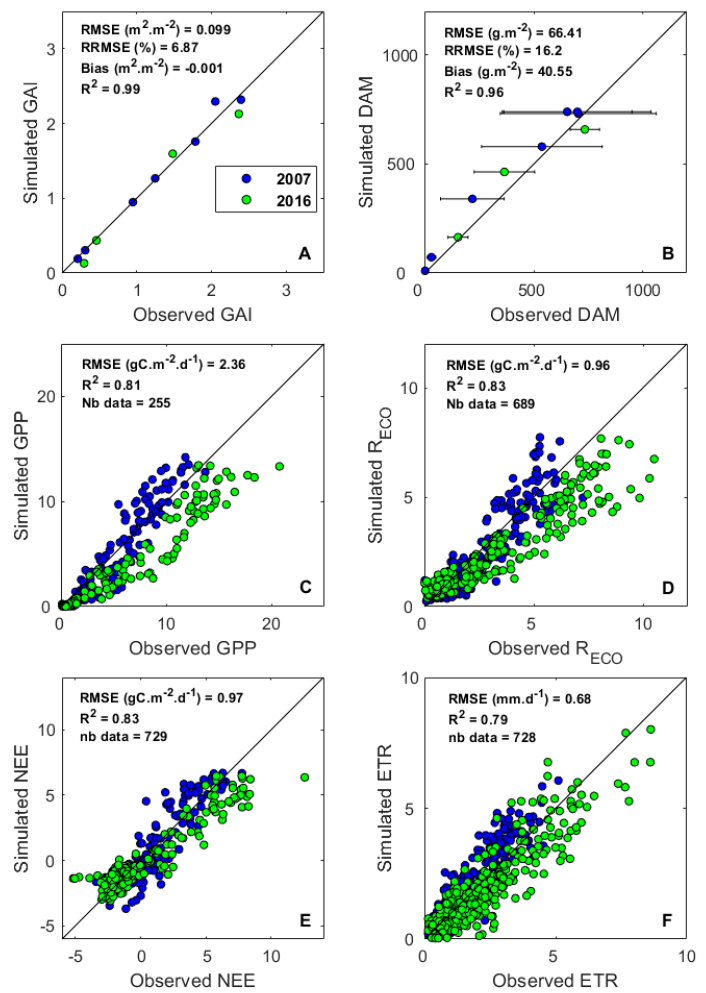
Figure 5. Scatter plots of the observed and simulated GAI ( A ), DAM ( B ), GPP ( C ), R ECO ( D ), NEE ( E ), and ETR ( F ) for the two crop years of sunflower at FR ‐ Aur and mean statistic over the 2 crop years. − 2 · − 1 0.96 gC · m d , respectively, and rRMSE of 39.5% and 40.9%, respectively) and good correlations (R 2 GPP and R ECO are estimated with relatively low errors (RMSE of 2.36 gC.m − 2 .d − 1 and 0.96 of 0.81 and 0.83, gC.m − 2 .d − 1 , respectively, and rRMSE of 39.5% and 40.9 %, respectively) and good correlations (R 2 of 0.81 and 0.83, respectively).